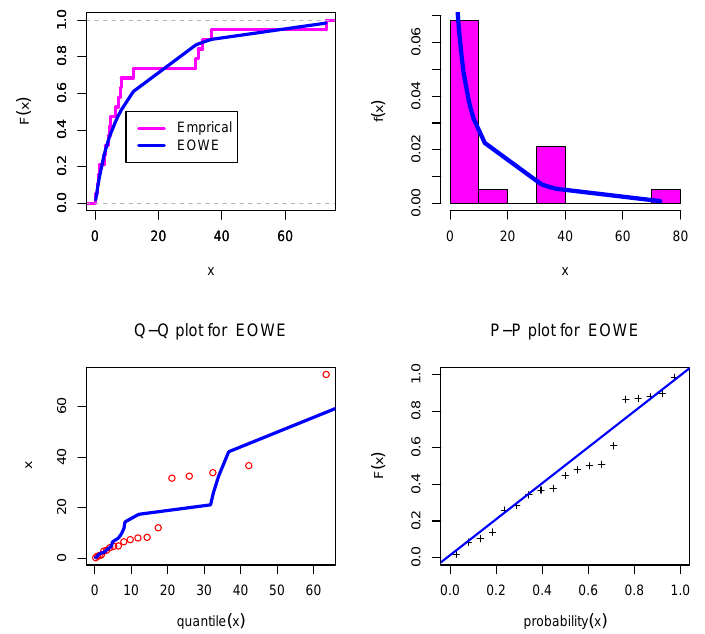
Figure 3. The estimated cumulative distribution function (CDF), fitted probability density function (PDF), PP-plot and QQ-plot of the EOWE distribution for complete electric